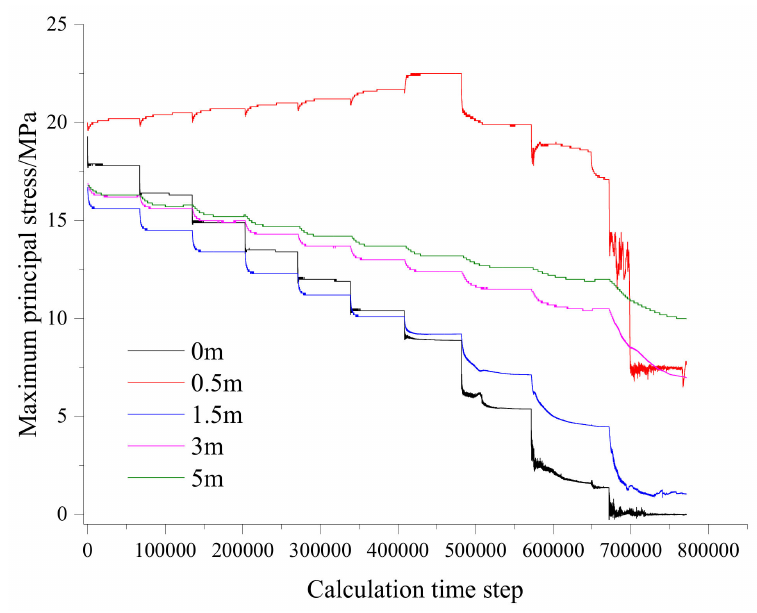
Figure 17. Maximum principal stress evolution characters in the critical points during the excavation unloading